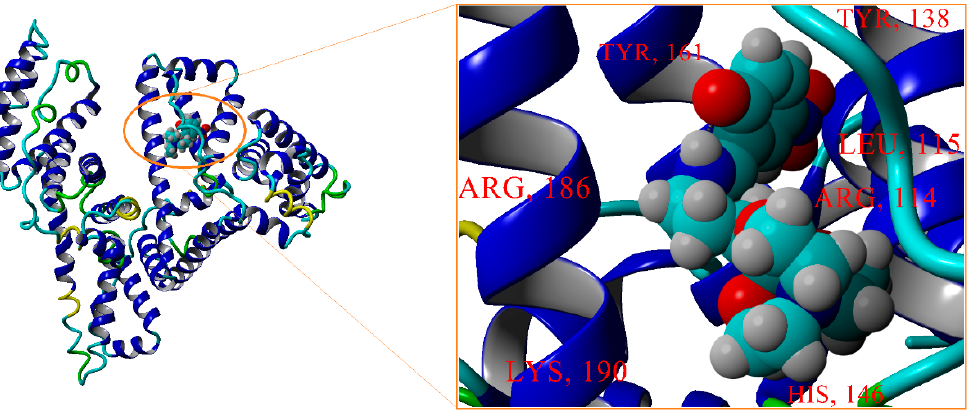
Figure 9. Molecular rendering of the best docked pose showing the interaction between HSA (receptor) and SIL-BS ligand; global docking view and zoom image. Table 4. Contacting receptor residues in docked complexes (by studied ligands SIL-M and SIL-BS), and calculated affinity estimators (relative binding energy and dissociation constant).